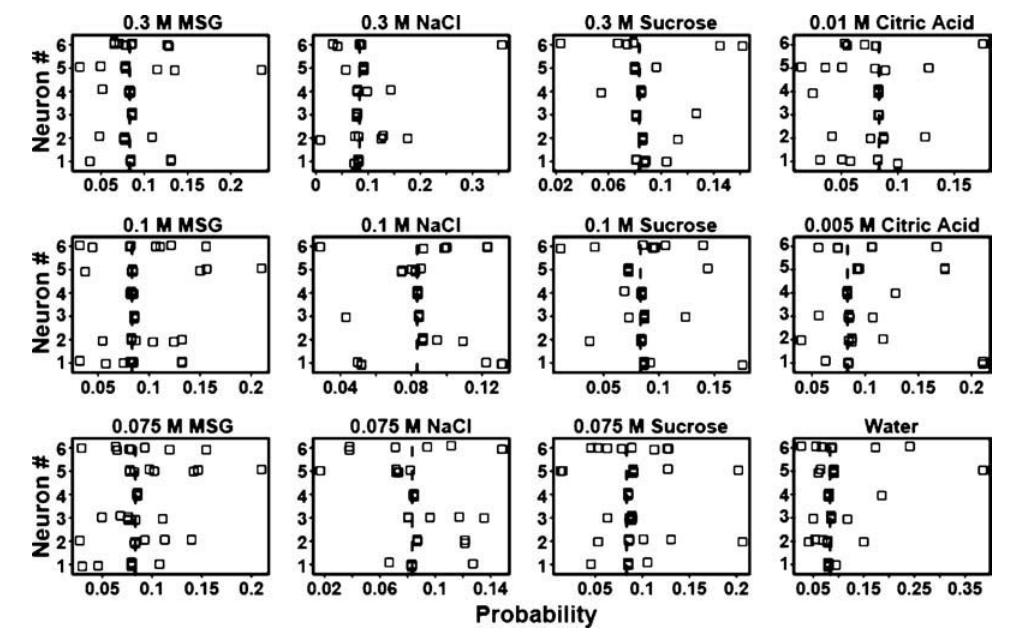
Figure 9. Single trial probabilities for non-chemosensory neurons of the same ensemble. Each panel depicts a stripchart of probabilities for the non- chemosensory neurons (n=6) of the same ensemble depicted in Figure 8 . Conventions are the same as those in the previous figure. Here most of the tastant probabilities cluster around chance (dashed vertical line), but some neurons do respond above chance to tastants. One example of this is neuron 5, which does respond to many trials of MSG at all concentrations above chance.